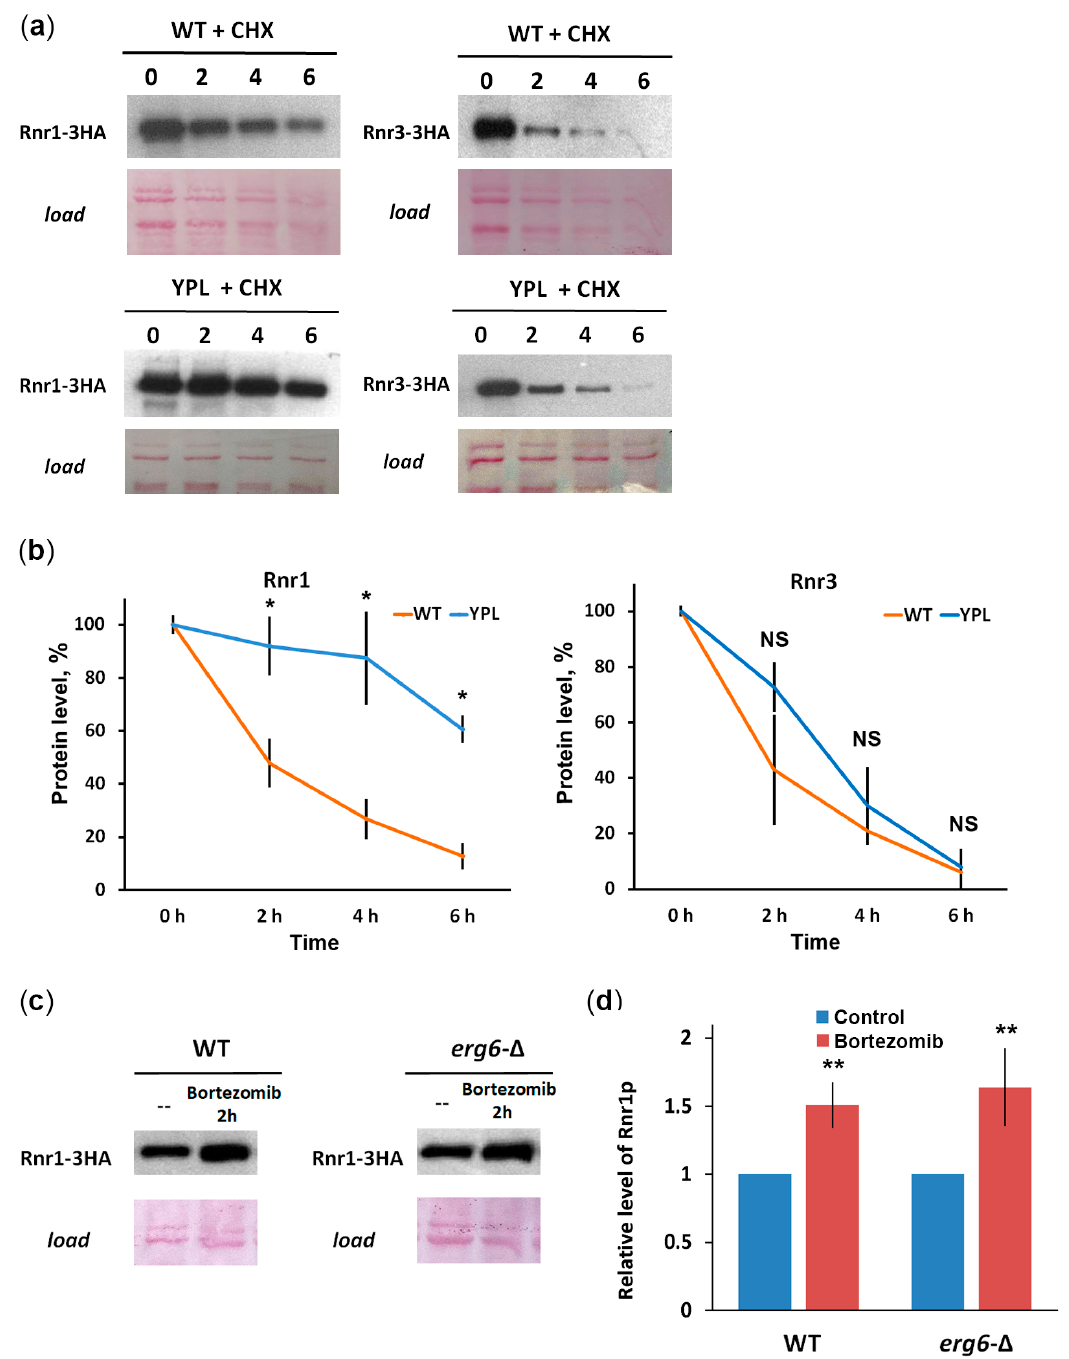
Figure 4. Evaluation of Rnr-3HA protein degradation kinetics by CHX chase. ( a ) Western blot results. Ponceau staining was used as a loading control. Numbers indicate hours of incubation with CHX. ( b ) Quantification of Western blot results with ImageJ after normalization to load density. Plots show mean values ( n = 2) ± SDs. Statistical significance: NS–nonsignificant; * p < 0.05, according to Student’s t -test. ( c ) Western blot analysis of Rnr1-3HA protein in WT or erg6 - ∆ strains after treatment with the proteasome inhibitor Bortezomib. Before analysis, yeast transformants in the exponential growth phase were treated with 200 µ M Bortezomib for 2 h at 30 ◦ C. Ponceau staining was used as a loading control. ( d ) Quantification of Western blotting results using ImageJ. The signal of the protein bands in WT was set to 1. Data represent the mean ( n = 2) ± SDs. Statistical significance: NS, not significant; ** 0.01 p < 0.001, according to Student’s t